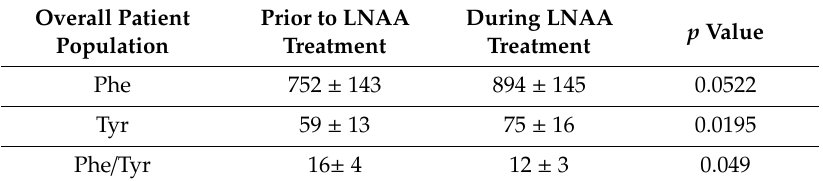
Table 3. Comparison between the mean values of Phe, Tyr, and Phe / Tyr ratio of all patients in the twelve months before starting LNAA treatment and during LNAA treatment. Overall Patient Prior to LNAA During Population Treatment